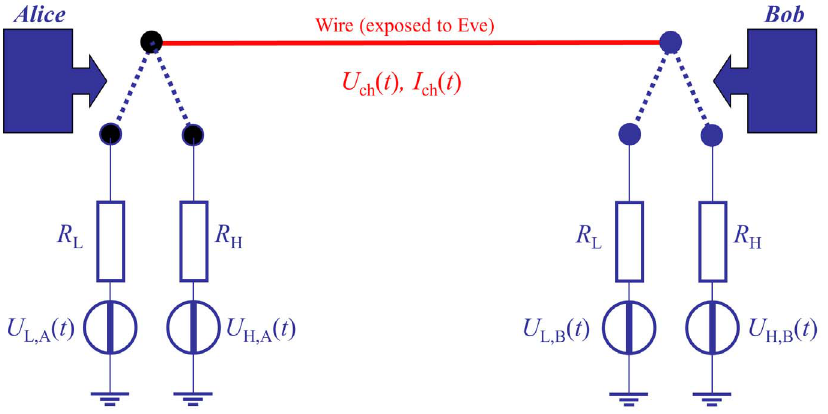
Figure 1. The core of the idealized KLJN key scheme [ 22–25 ] . This simple system is secure only against passive attacks in the idealized case (mathematical limit). Security enhancements (including filters) to provide protection against invasive attacks [22–25] and against other types of vulnerabilities are not shown. In practical applications electronic noise generators emulate an enhanced Johnson noise with a publicly agreed high effective temperature.